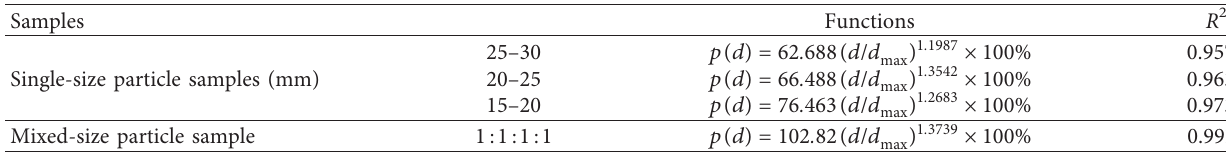
Table 2: The particle size distribution functions.